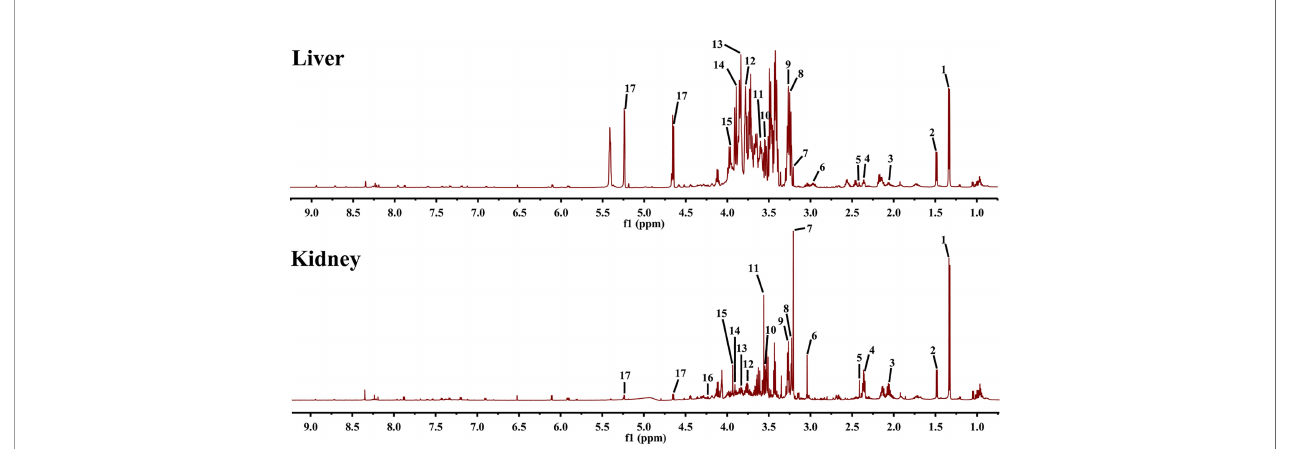
FIGURE 5 | 1 HNMR spectra of liver and kidney extracts (1, lactate; 2, alanine; 3, methionine; 4, glutamate; 5, pyruvate; 6, creatine; 7, phosphocholine; 8, betaine; 9, taurine; 10, glycine; 11, glycerol; 12, lysine; 13, serine; 14, aspartate; 15, cysteine; 16, threonine; and 17, glucose).